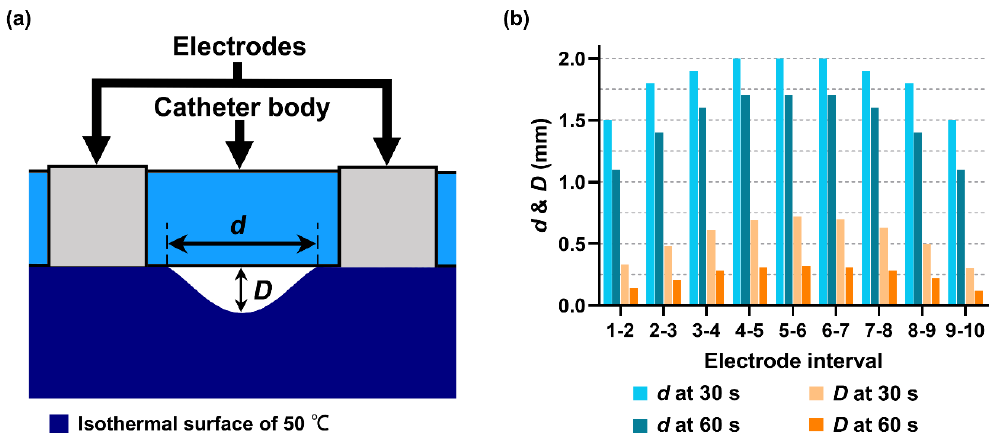
Figure 5. ( a ) Concave of the lesion between the adjacent active electrodes in the MEU mode. The minimum distance between adjacent lesions on the tissue surface is defined as d . The depth of the concave is defined as D . ( b ) The values of d and D at 30 s and 60 s of RFCA.